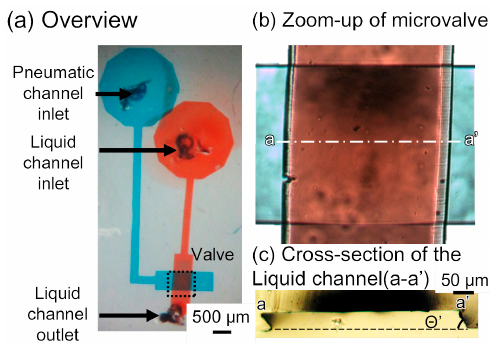
Figure 5. Microfluidic device with the microvalve for a tall microchannel. ( a ) Overview of the microfluidic device; ( b ) Zoom-up of the microvalve; ( c ) Cross-section of the liquid channel (a-a’).